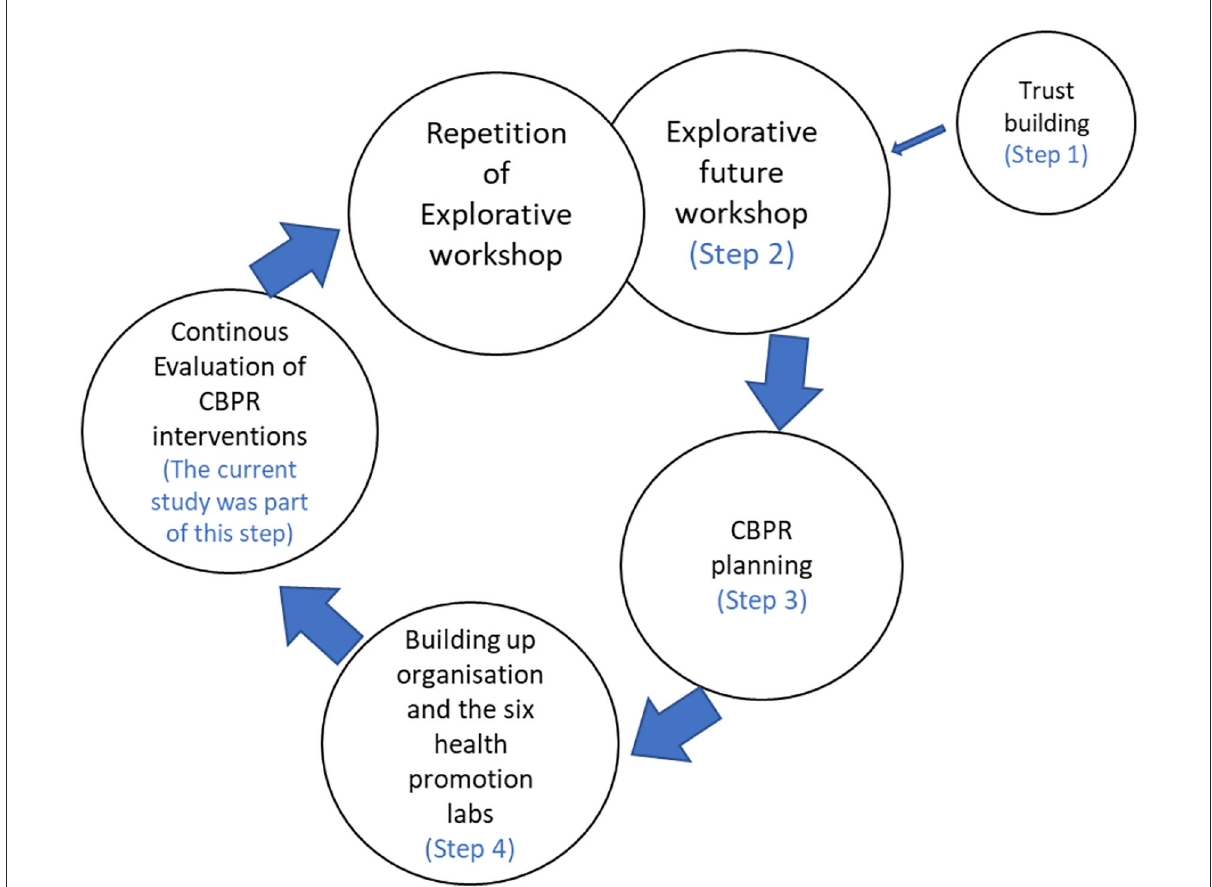
FIGURE1 Steps within the Equal Health